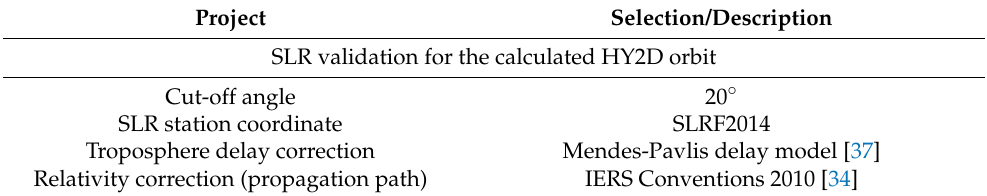
Figure 5. Variation of residuals in the POD for HY2D using spaceborne GPS data. 4.2. POD Precision Analysis for HY2D